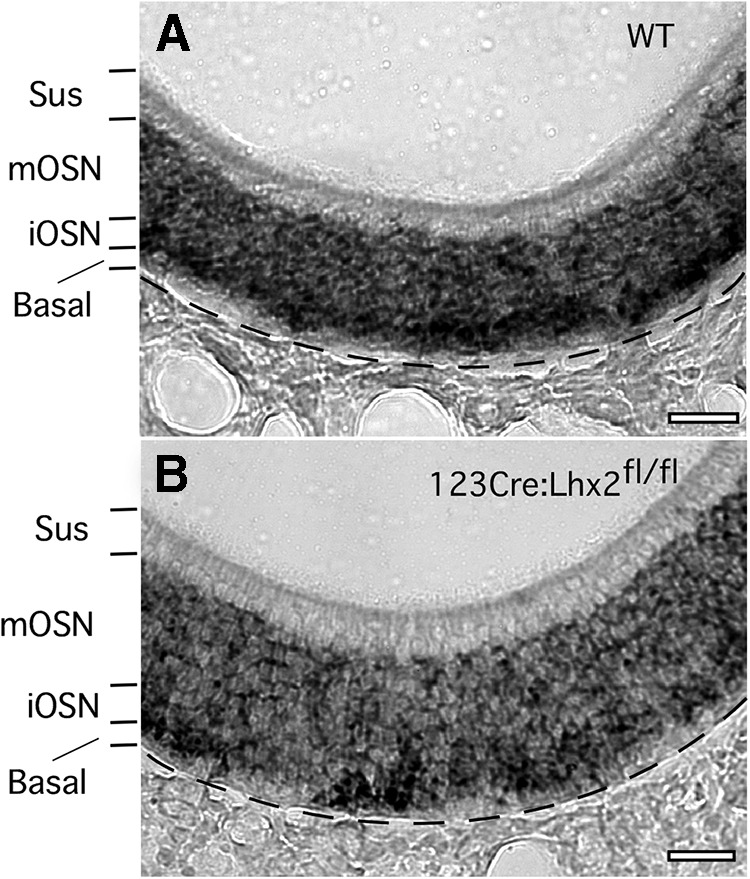
Most OSNs in 123Cre:Lhx2fl/fl mice continue to express Lhx2. A, In situ hybridization for Lhx2 mRNA in a wild type (WT) mouse. B, In situ hybridization for Lhx2 mRNA in a 123Cre:Lhx2fl/fl mouse. Sus, Sustentacular cell layer; mOSN, mature OSN cell layer; iOSN, immature OSN cell layer; Basal, basal cell layer. Scale bars, 40 µm.